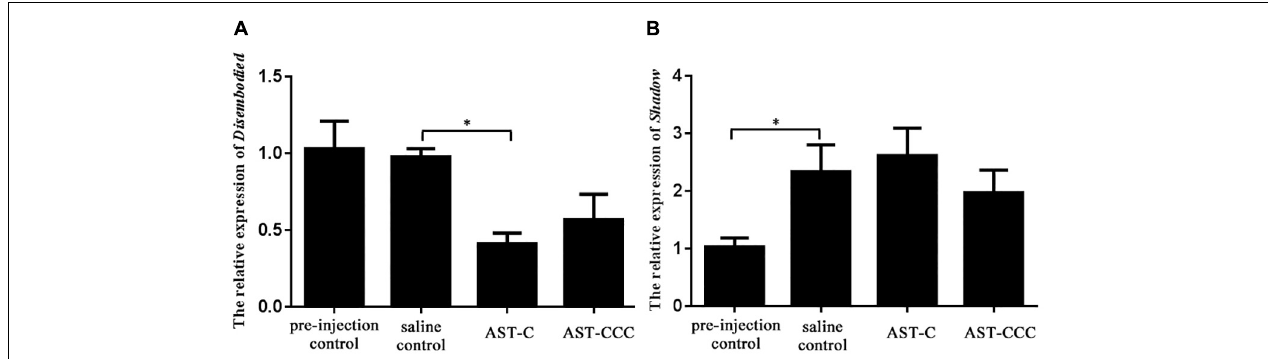
FIGURE 4 | In vivo effect of synthetic Scypa AST-C and Scypa AST-CCC peptides on the abundance of 20E biosynthetic enzyme gene expression in Y-organ. (A) The abundance of disembodied gene expression in Y-organ; (B) the abundance of shadow gene expression in Y-organ. Result were shown as means ± SEM ( n = 7). Asterisk “ ∗ ” on the error bars indicates the significant difference from the saline control ( P < 0.05).